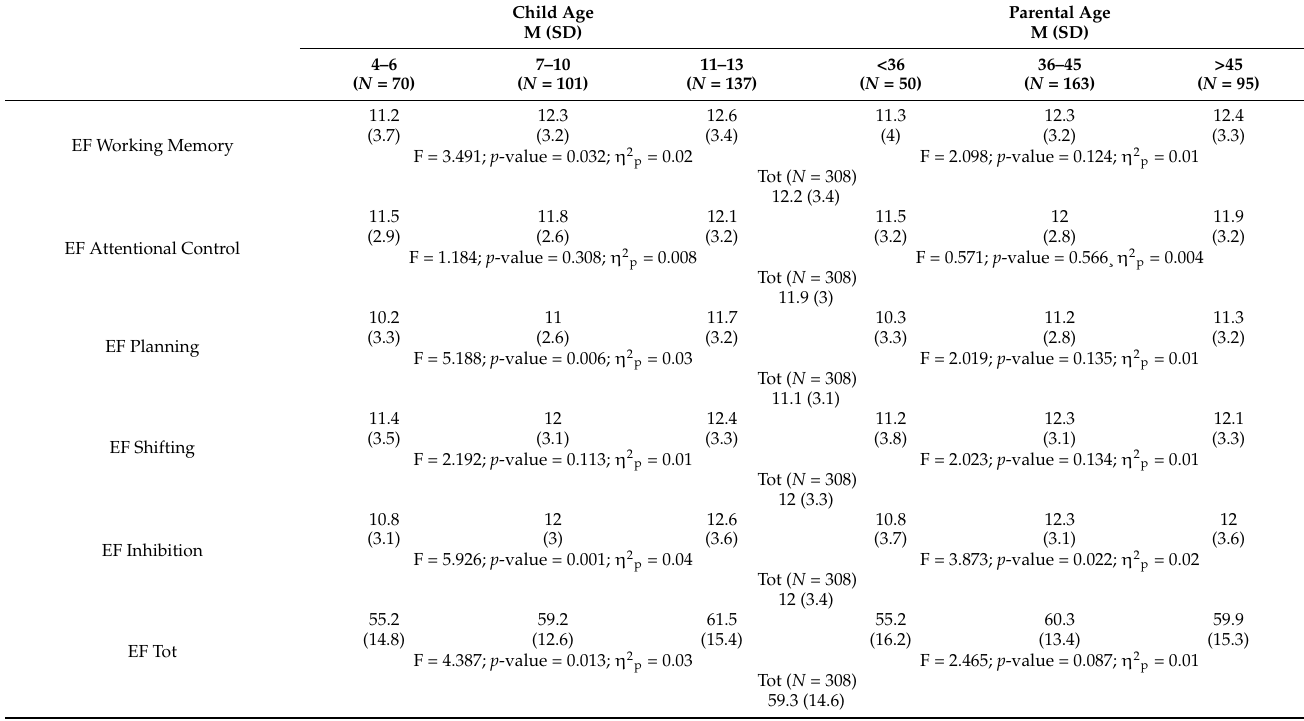
Table 7. EF descriptive data and ANOVA analysis for child and parental age.